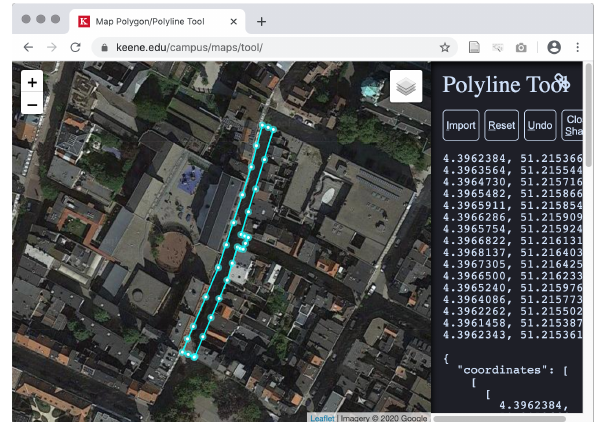
Figure 5. The Antwerp dashboard requires a web application that allows users to select/propose new garden street locations for input evaluation by drawing polygons on a map.